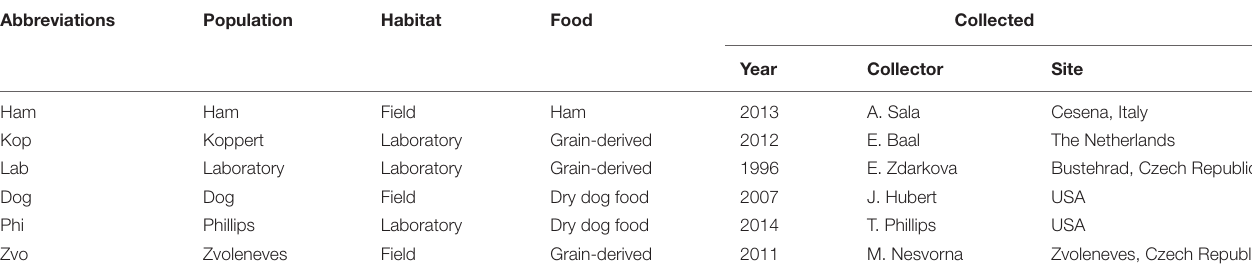
TABLE 1 | Sampled populations of Tyrophagus putrescentiae and their habitats at the time of collection. Abbreviations Population Habitat Food